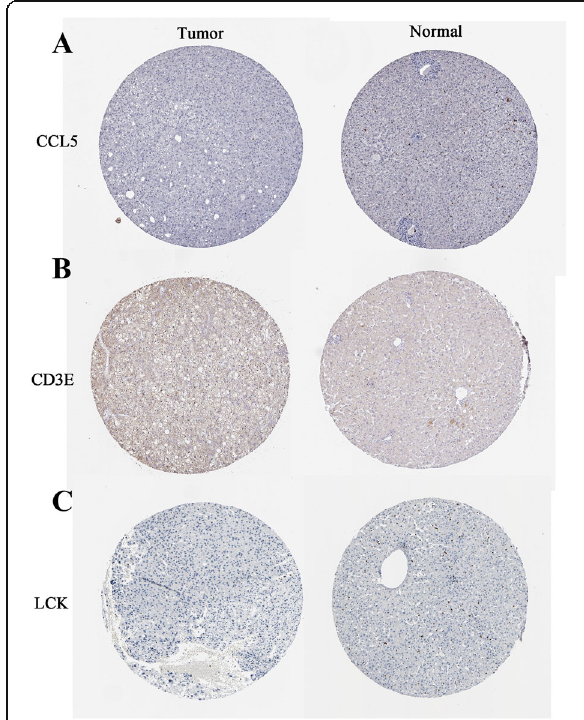
Fig. 11 Immunohistochemical analysis of CCL5 ( A ), CD3E ( B ) and LCK ( C ). Normal and Tumor indicate adjacent non-tumor samples and HCC samples, respectively. HCC: hepatocellular